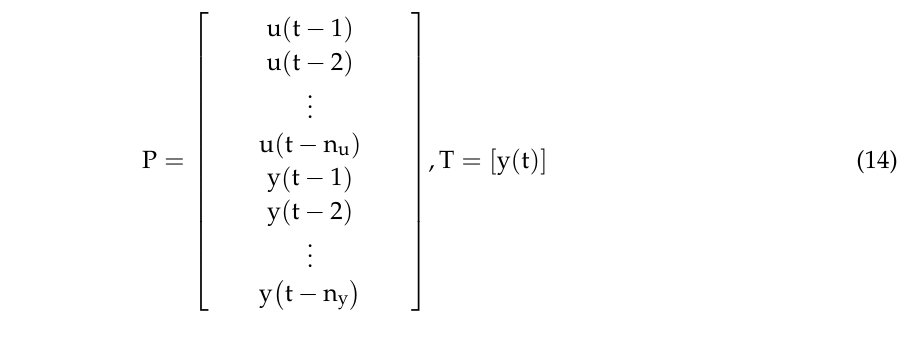
Figure 8. Series-parallel architecture for training a NARX.